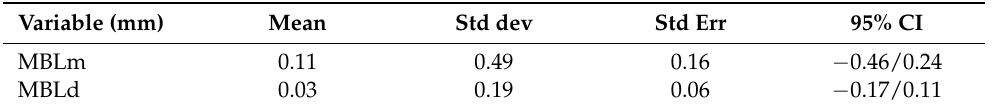
Table 1. The mean change in bone position at the mesial and distal site, between the radiographs taken after implant loading, and at the final follow-up appointment. Variable (mm) Mean Std